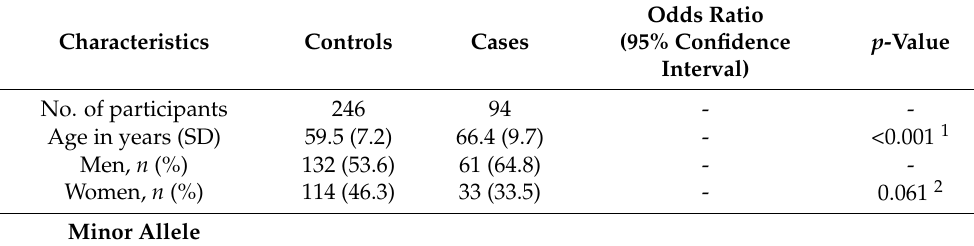
Table 1. Demographic characteristics and distribution of minor allele frequency of DICER1 rs3742330